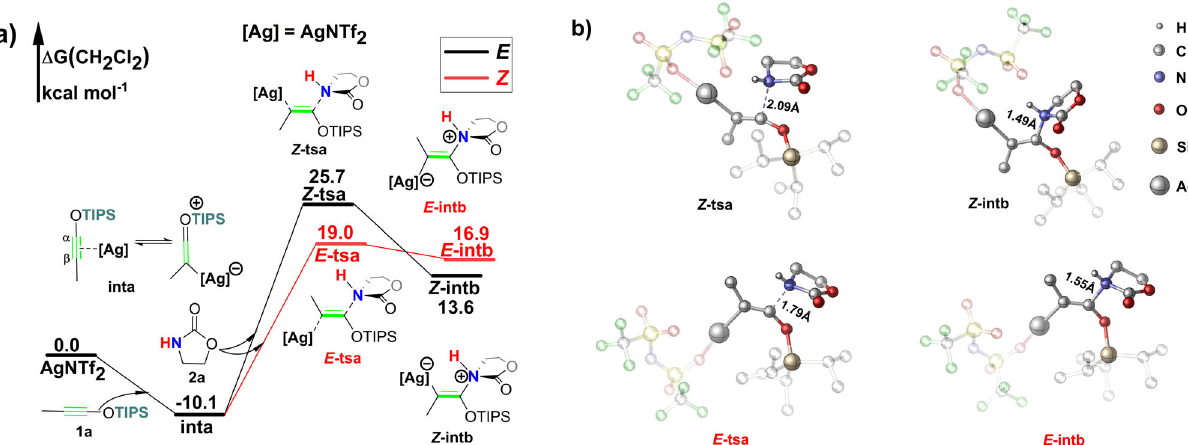
Fig. 3 Ag + induced nucleophilic attack between siloxy-alkyne and amide. a Gibbs free-energy pro fi le. Gibbs free energies are in kcal mol − 1 . b Optimized geometries. The hydrogen atom was omitted, the isopropyl of triisopropylsilyl (TIPS) group and NTf 2 - anion was set to transparent